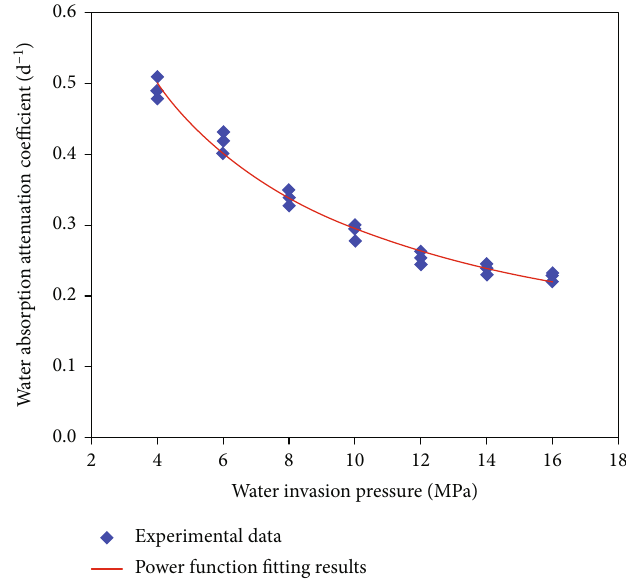
Figure 4: Relation between water absorption attenuation coe ffi cient and water invasion